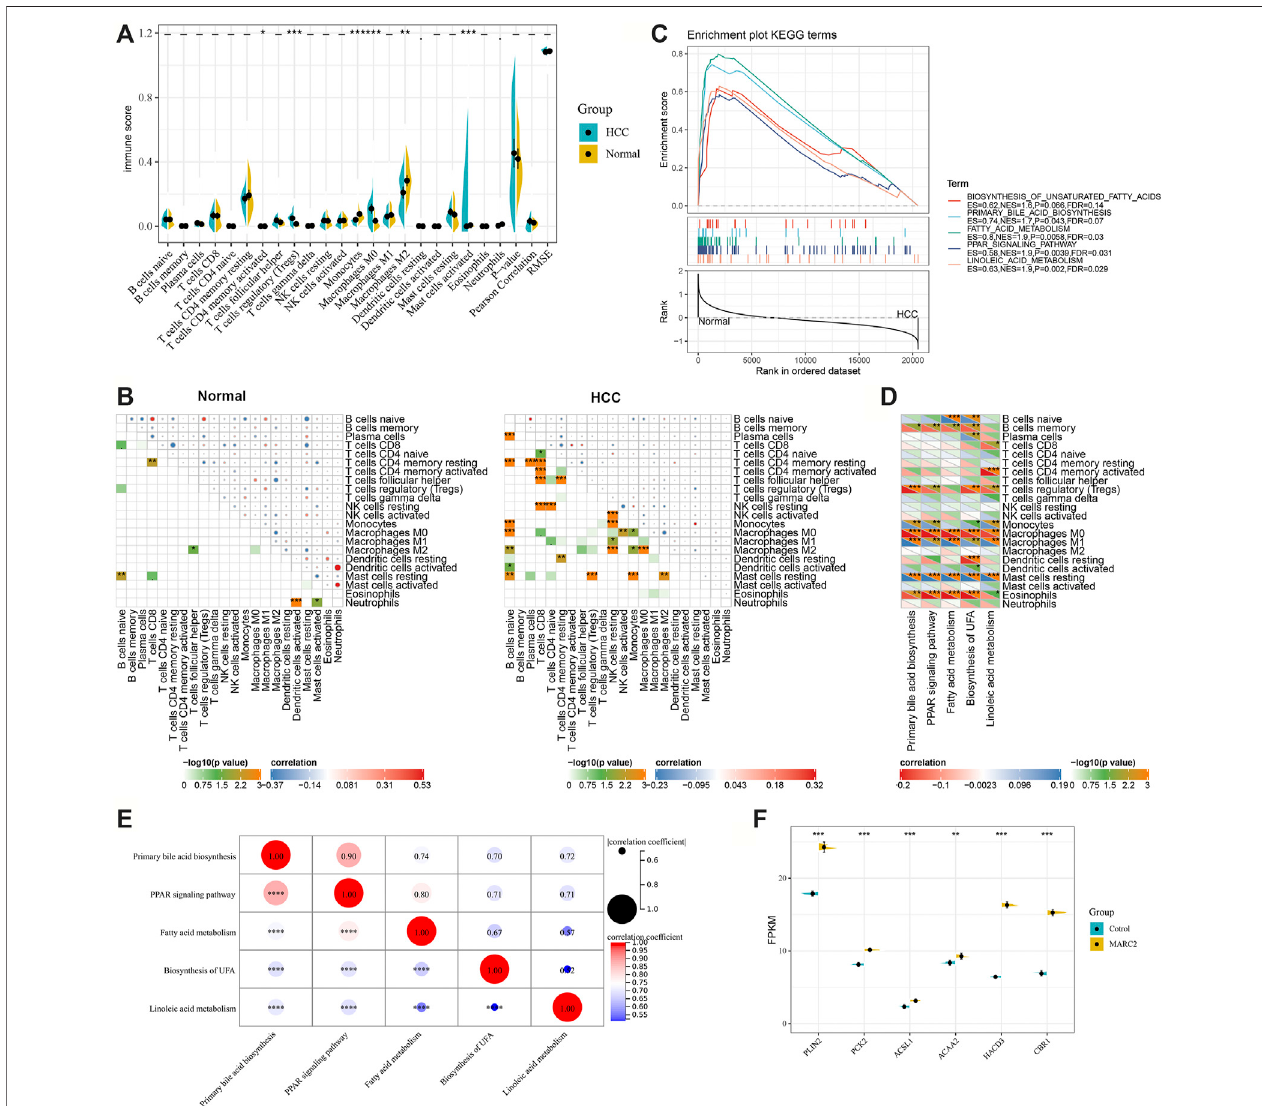
FIGURE 5 | There was a correlation between MARC2-related lipid metabolism and immune modi fi cation. (A) Compared different immune cell types between normal and tumor tissues. (B) The interaction of immune cell types in normal and tumor tissues. (C) GSEA results revealed MARC2 related lipid metabolism signaling pathways. (D) The correlation between MARC2 related lipid metabolism signaling pathways and immune cell types. (E) The correlation between MARC2 related lipid metabolism signaling pathways. (F) Overexpression MARC2 in HCCLM3 cell line could regulate the expression of genes related to lipid metabolism. The Pearson correlation coef fi cient was used to determine the correlation. *p < 0.05; **p < 0.01; ***p < 0.001; ***p <